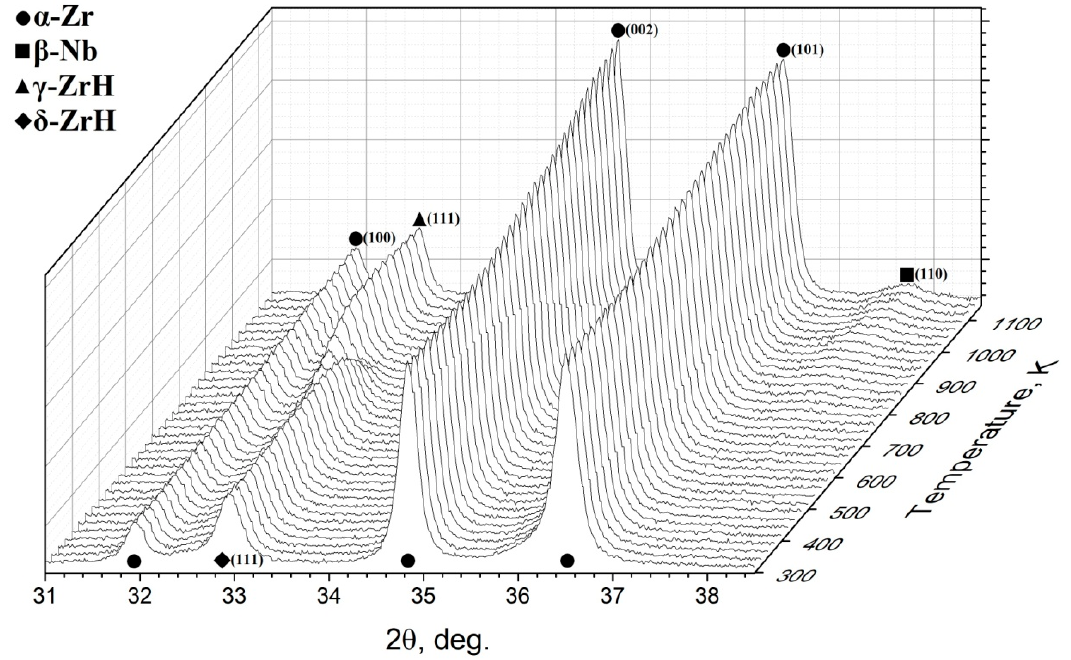
Figure 2. Parts of the diffraction pattern of the FG Zr–1Nb–0.33H alloy upon heating to 1173 K.